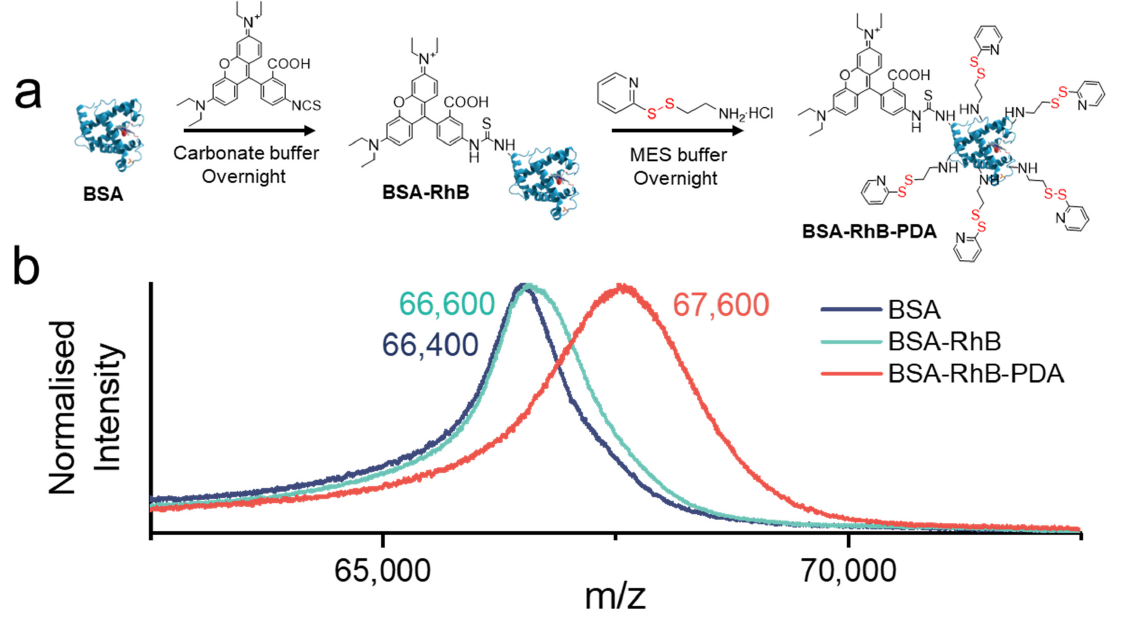
Figure 4. ( a ) Synthetic route of BSA modification with rhodamine B isothiocyanate (RhB) and disulfide bonds (PDA). ( b ) MALDI-TOF spectra in the [ M + X] + (X: Na or H) range of BSA, BSA-RhB, and BSA-RhB-PDA, respectively.